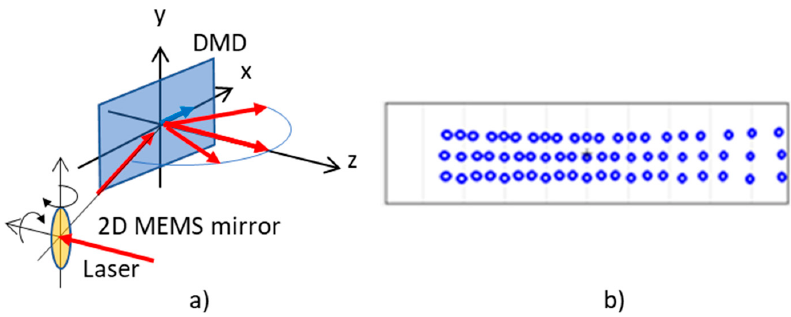
Figure 14. ( a ) Arrangement of the 2D-MEMS mirror and DMD as in-plane illumination and ( b ) corresponding beam pattern over 7 sub-FOVs. The in-plane geometry eliminates the arc-like scanning pattern found in the out-of-the-plane geometry. Slight distortion of the scanning pattern is observed at the edge of the FOV due to the non-linearity in the grating equation.